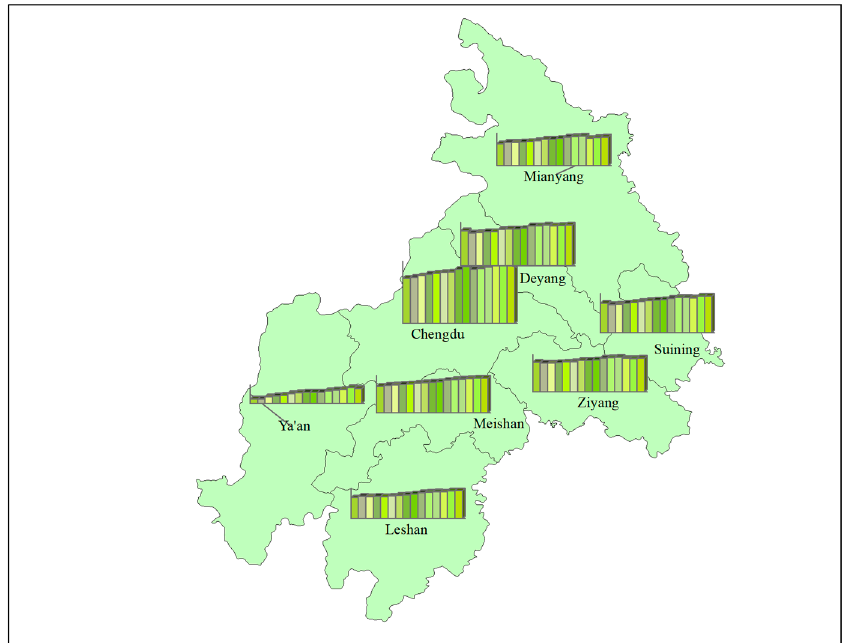
Figure 7. Coupling coordination degree change trends.